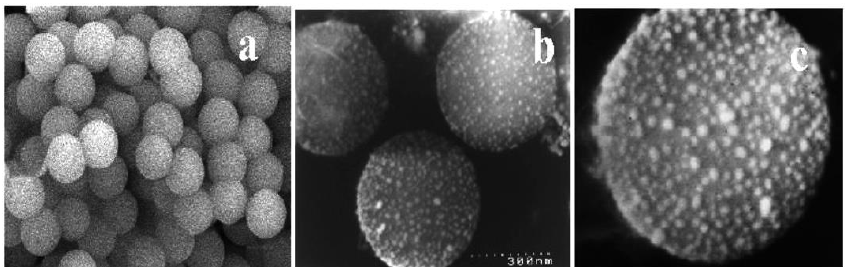
Figure 4. Silica submicrospheres as seen through scanning electron micrographs of ( a ) bare silica; and ( b ) coated with gold nanoparticles. The image next to ( c ) shows a higher resolution micrograph of submicrospheres coated with gold nanoparticles. Reprinted with permission from Reference [46]. Copyright (2003) American Chemical Society.